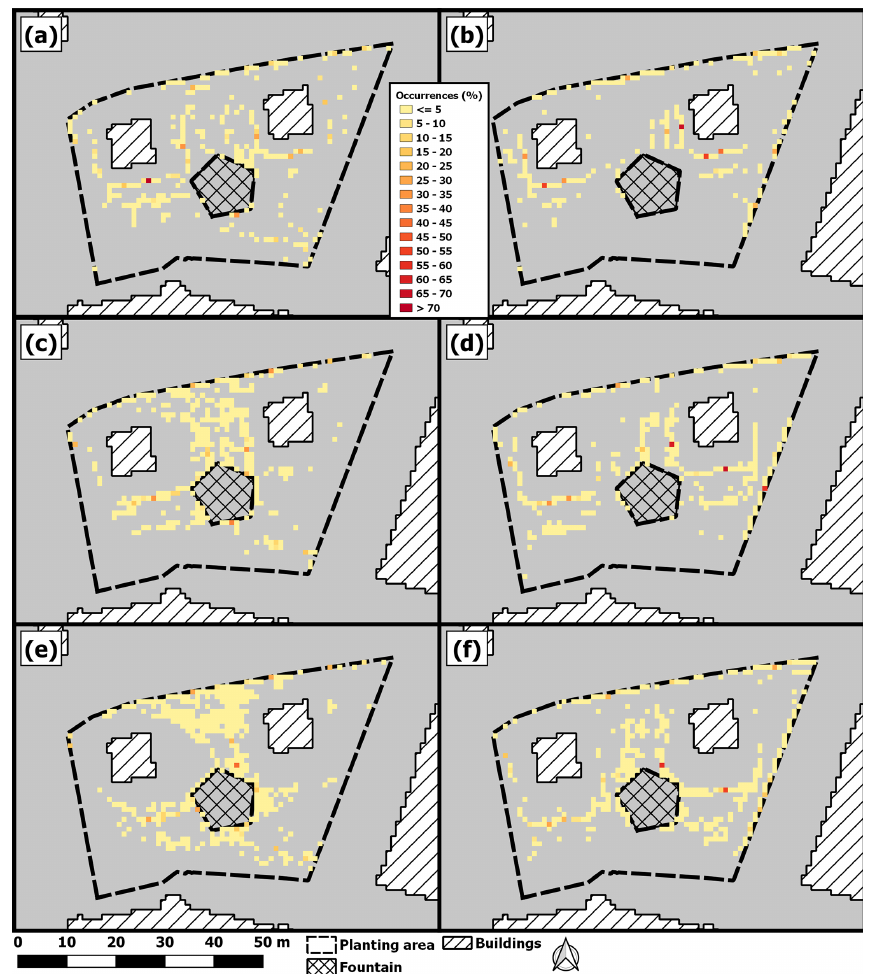
Figure 11. Occurrence maps showing percentage of times pixels were found to be an optimal tree position based on model runs with five trees, the random starting algorithm and 20000 iterations. Gray indicates zero occurrences. Maps in panels (a) and (b) are for small trees, (c) and (d) are for medium trees and (e) and (f) are for large trees. The left column (a, c, e) is for 09:00–16:00LST and the right column (b, d, f) is for